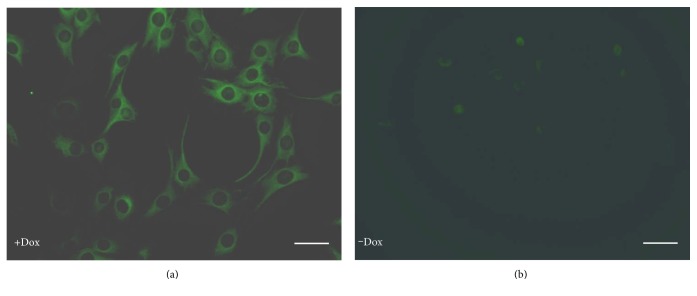
Regulatable EGFP expression from hTERT-BMSCs/Tet-on/GAL cells in the presence and absence of Dox in vitro (×400). hTERT-BMSCs transfected with LV.TetIIP-GAL-EGFP-/Ubi-TetR showed strong green fluorescence after treatment with 1 μg/mL Dox for 48 h (a), whereas very faint fluorescence was observed without Dox induction (b). Scale bar: 200 μm.